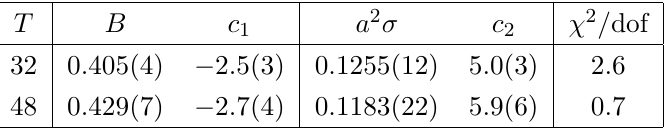
Table 1 . Global (cid:12)t results for the static potential with T = 32. We used (cid:28) = 2 in eq. (3.16) to determine aV ( r